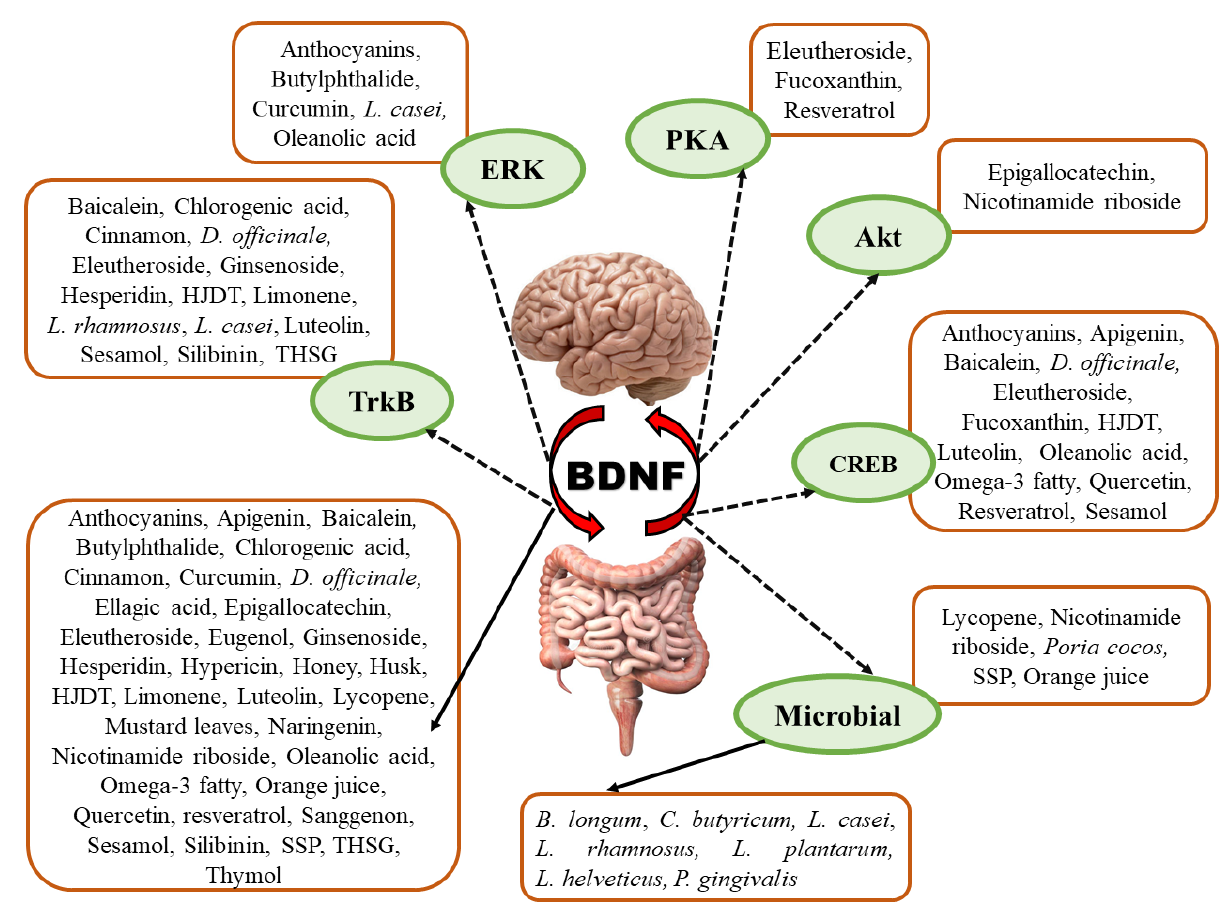
Figure 2. Modulation of BDNF signaling by different natural products. BDNF, brain-derived neu- rotrophic factor; TrkB, tropomyosin receptor kinase B; Akt, serine/threonine protein kinase; CREB, cAMP response element binding protein; ERK, extracellular signal-regulated kinase; PKA, protein kinase A; HJDT, Huanglian-Jie-Du-Tang; THSG, 2,3,5,4 ′ -tetrahydroxystilbene-2- O - β -d-glucoside; SSP, Semen Sojae Praeparatum.